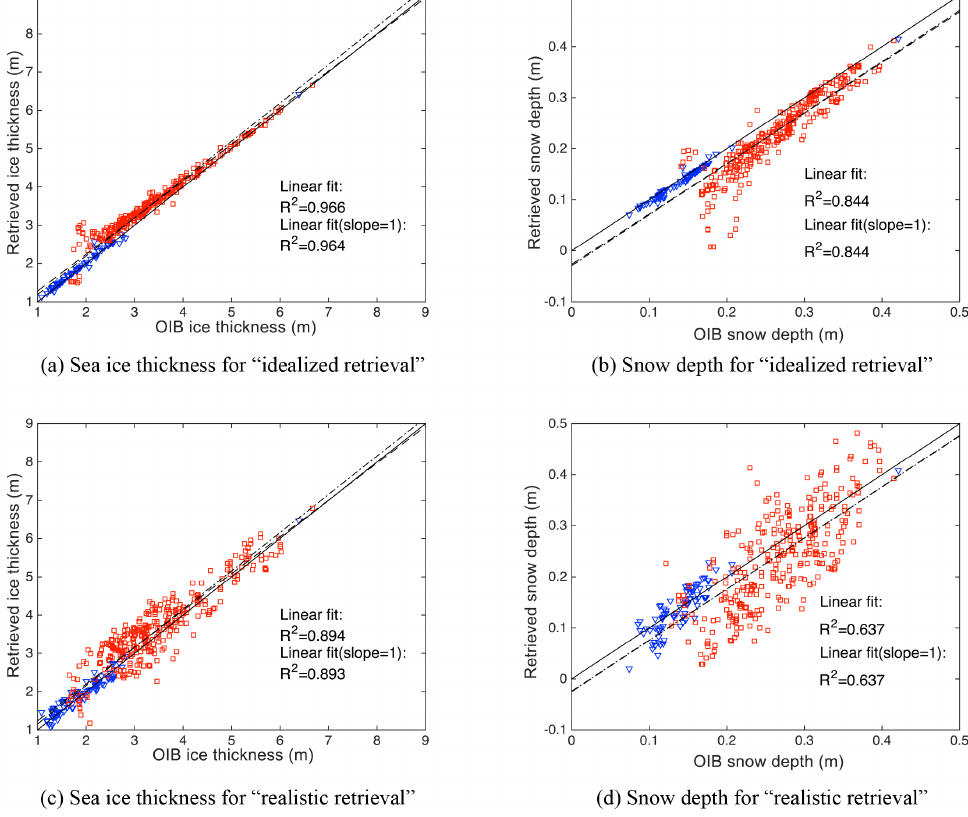
Figure 8. Large-scale retrieval of mean sea ice thickness (a, c) and mean snow depth (b, d) and verification with OIB observations. In each panel, blue triangles (red rectangles) denote FYI (MYI), the solid line is the 1 : 1 line and the dashed (dashed dotted) line represents the linear fitting (linear fitting line with the constraint that the slope be 1). The quality of fittings in terms of R 2 are also shown. Panels (a, b) represent the comparison results for the retrieval with modeled TB and the local values of s . Panels (c, d) represent the results with SMOS TB and the global values of s as derived from OIB